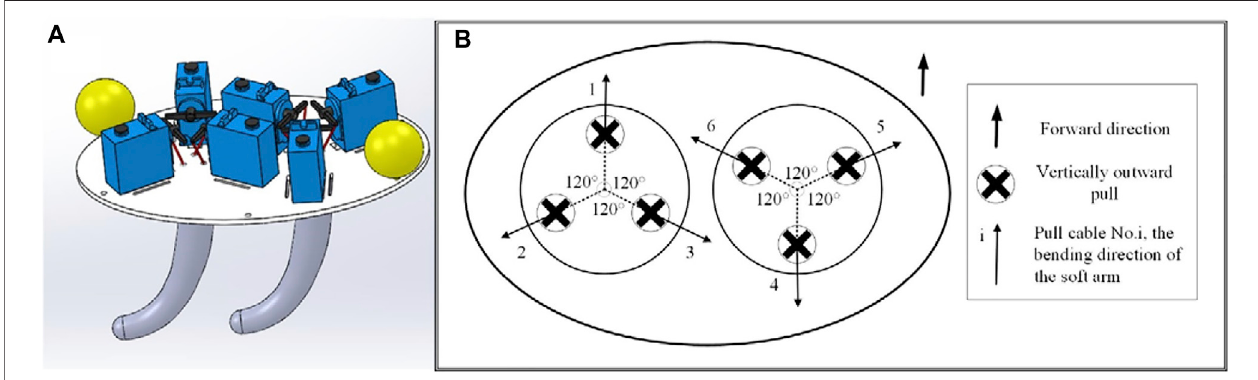
FIGURE 10 | (A) The assembly of the octopus-inspired soft robot (B) Distribution of double-arm drive cables, tension direction and bending direction.